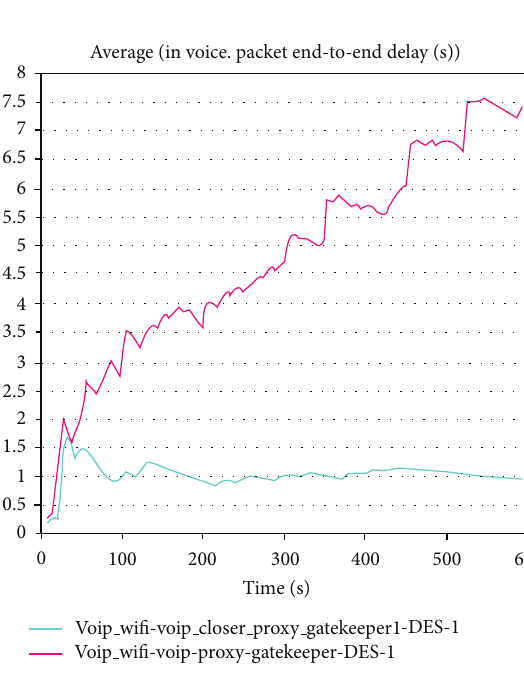
Figure 8: Received traffics.